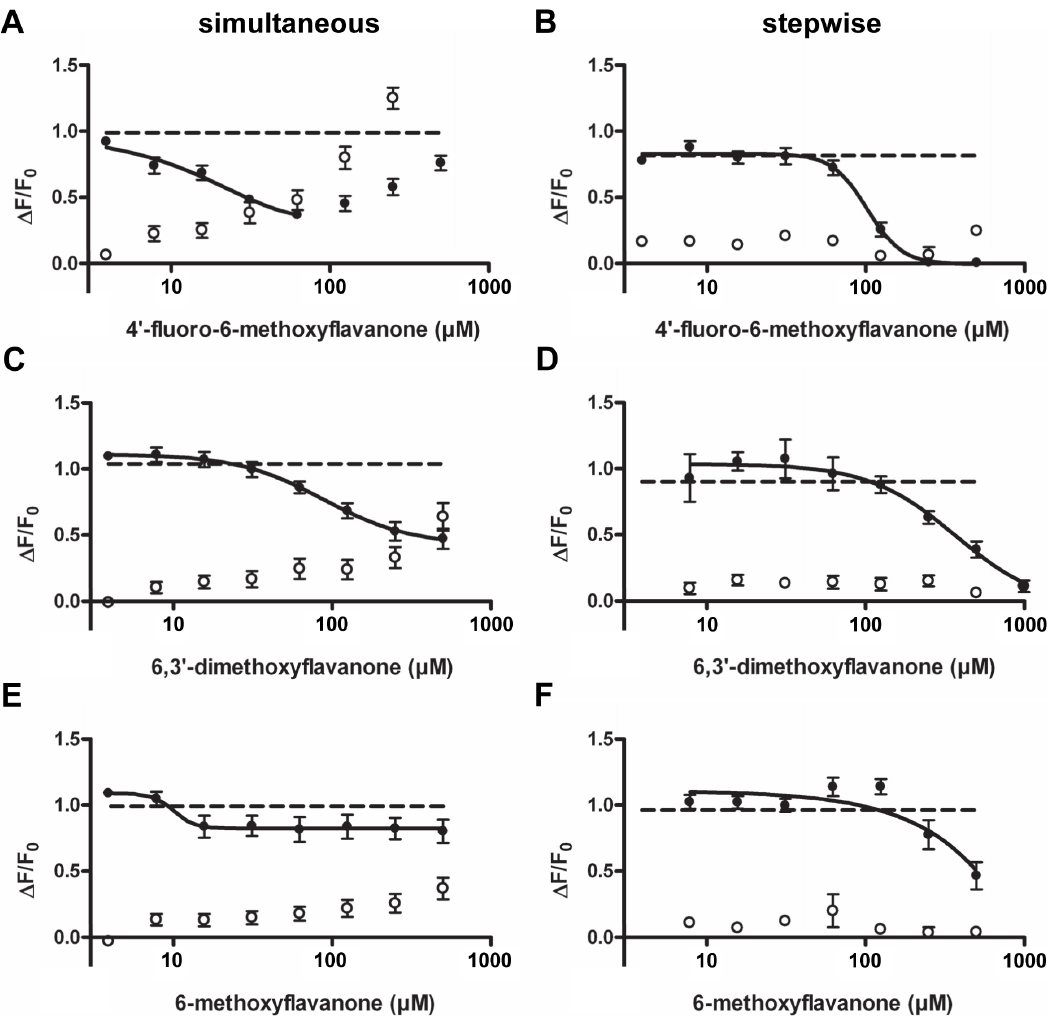
N # ))by49-fluoro-6-methoxyflavanone(6)after Figure4.Inhibitionofresponseof200 m MECG (---) onhTAS2R39(induced ( ),non-induced( simultaneous addition (n=5) (A) and stepwise addition (n=4) (B), by 6,39-dimethoxyflavanone (3) after simultaneous addition (n=4) (C) D), and by 6-methoxyflavanone (11) after simultaneous addition (n=5) (E) and stepwise addition (n=3) (F). Table 2. Thresholds and IC 50 values of 6-methoxyflavanones for inhibition of hTAS2R39 responses towards 200 m M ECG and 1.7 mM denatonium